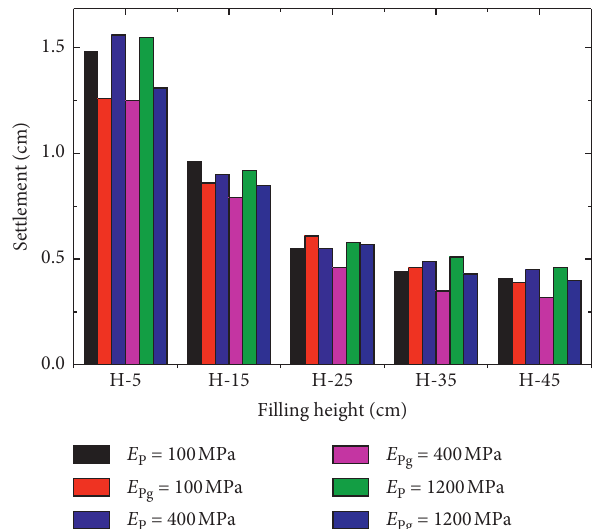
Figure 15: Comparison of the settlement between unreinforced and reinforced